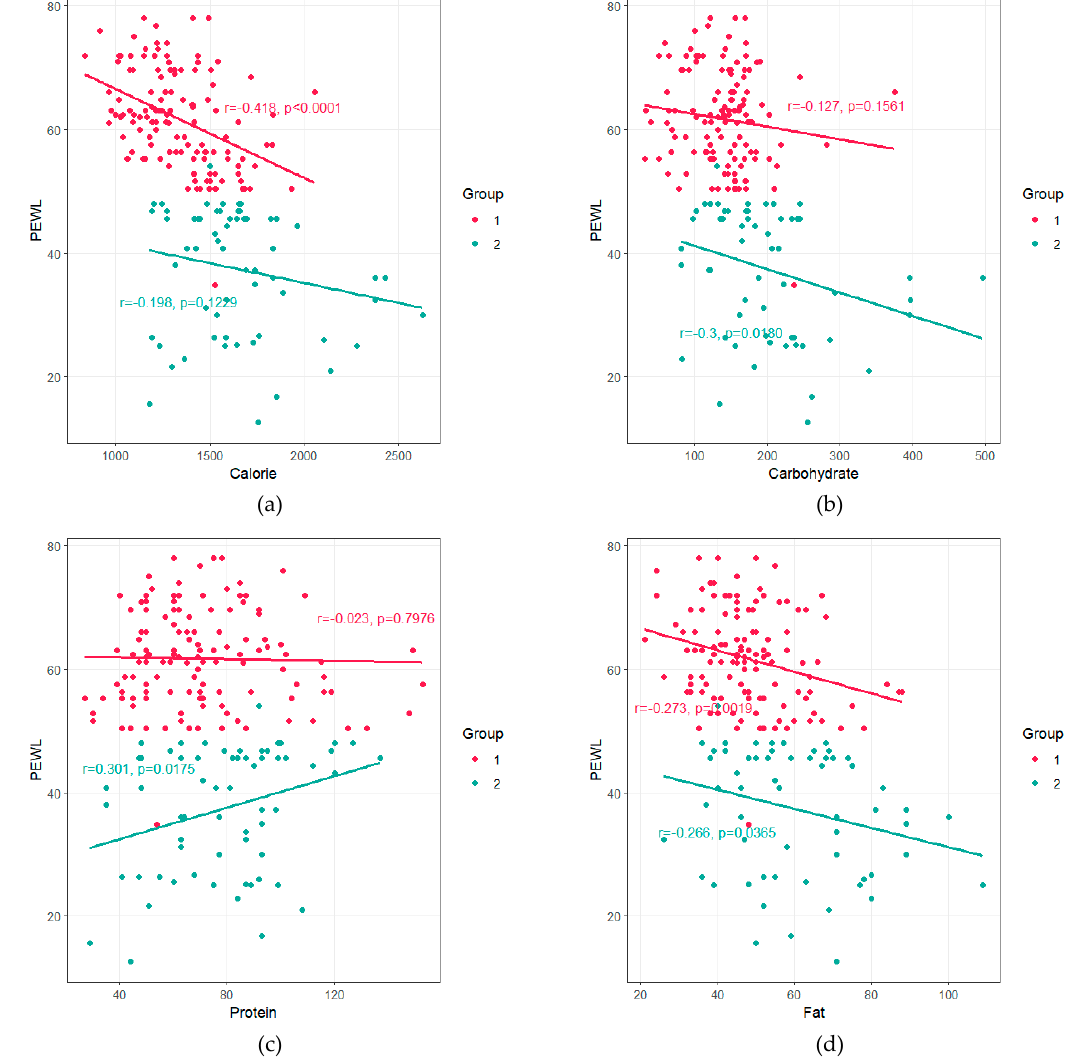
Figure 1. Scatterplot representing the association between %EWL and macronutrient composition at postop 12 months. ( a ) correlation between %EWL and calorie, ( b ) correlation between %EWL and carbohydrate, ( c ) correlation between %EWL and fat, ( d ) correlation between %EWL and fat. Group 1; Success, Group 2; Failure. P -value was computed by pearson correlation test.